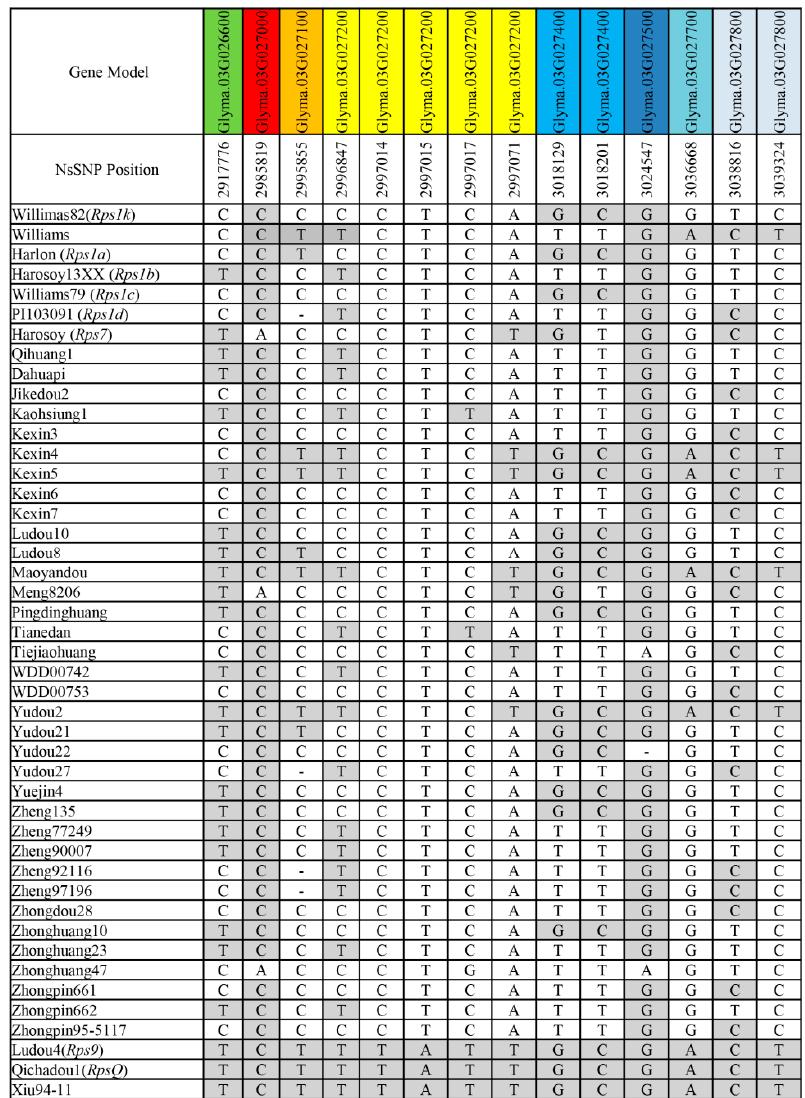
Figure 3. Nonsynonymous SNPs located in the corresponding gene models of the RpsX mapping interval among 45 soybean genotypes. Different gene models are presented in different colors. A base in a white background is the same as that in the PRR ‐ susceptible parent Zhonghuang47, whereas a base in a gray background is the same as that in the PRR ‐ resistant parent Xiu94 ‐ 11.